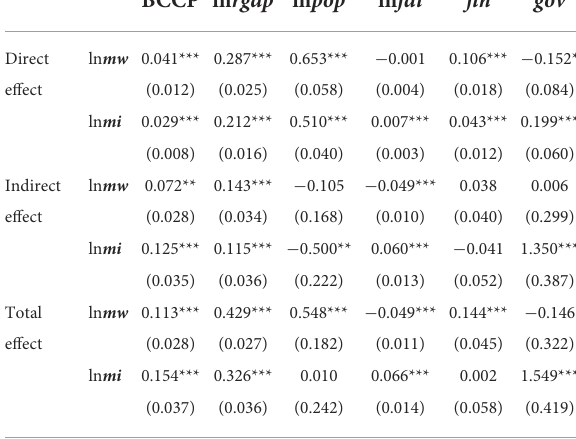
TABLE 5 Direct effect, indirect effect, and total effect of SDM in Table